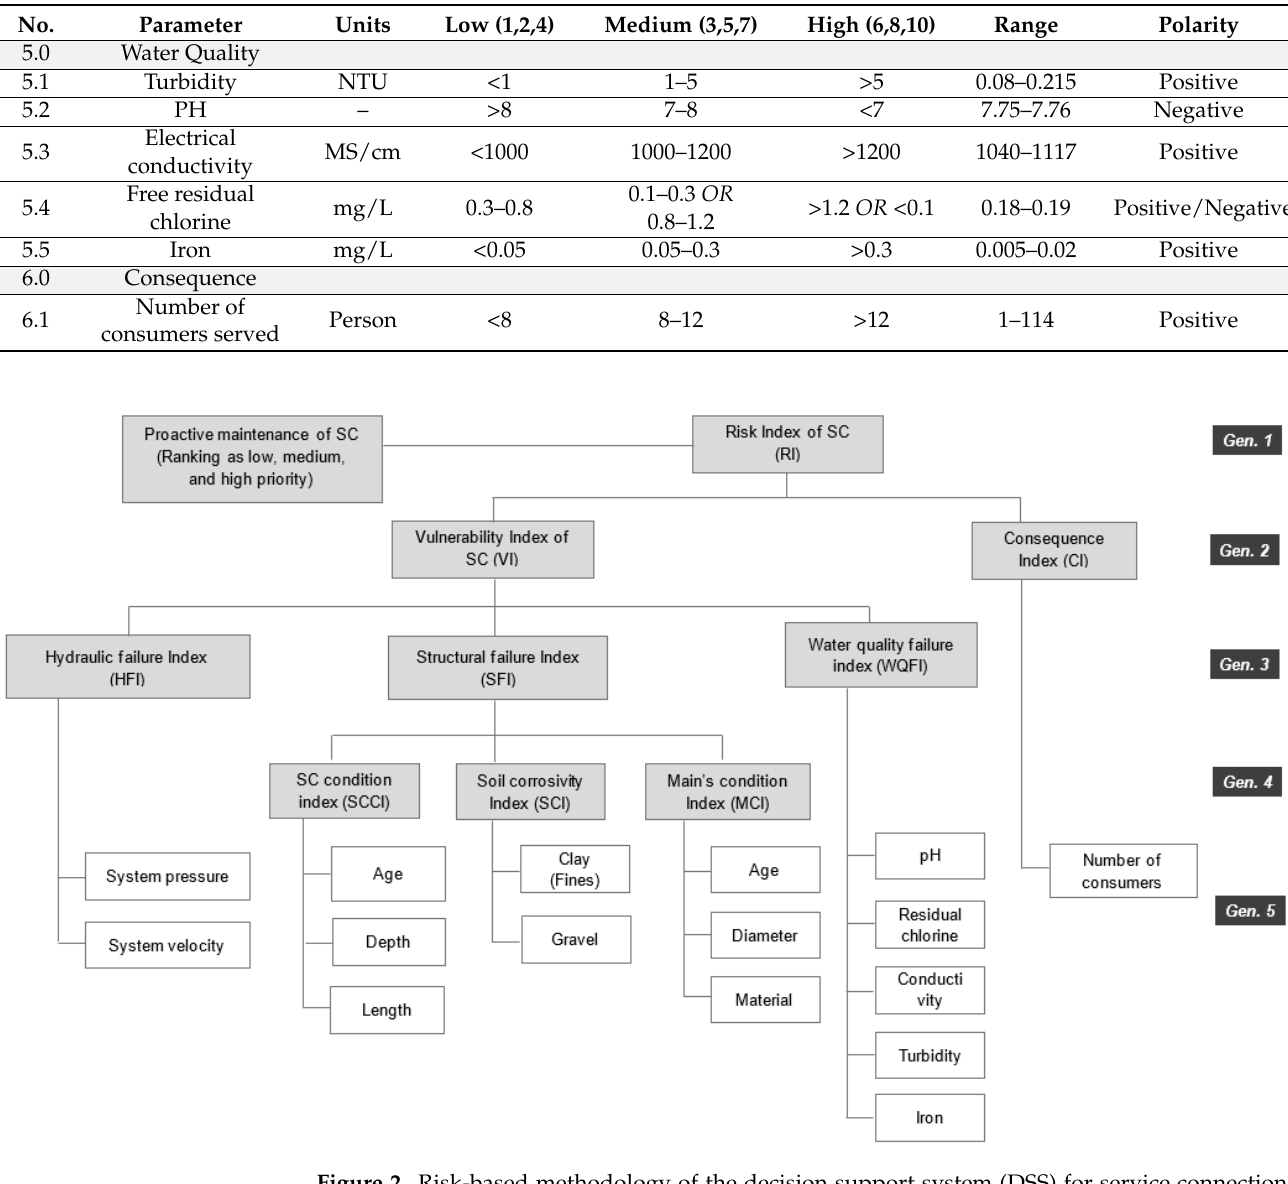
Figure 2. Risk-based methodology of the decision support system (DSS) for service connections’ proactive maintenance